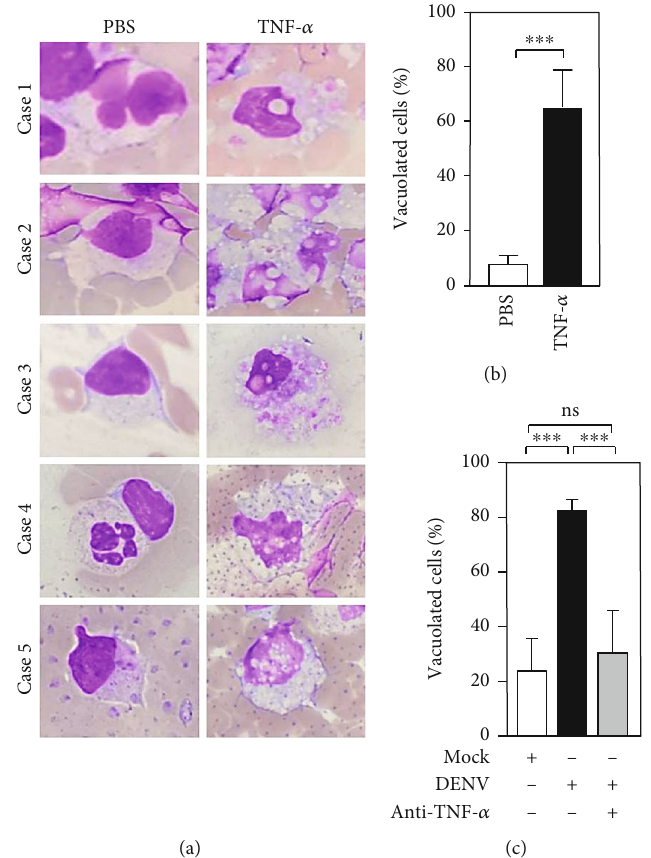
Figure 6: Abnormal TNF- α determines the cytopathological e ff ects 24h postincubation. Without DENV coculture, hTNF- α (100ng/ml) was added to the ex vivo culture of WB for 24 h. (a) Image analysis, shown by an oil immersion fi eld (100x objectives), was performed using the Wright-Giemsa stain to show the induction of vacuolization in fi ve cases. (b) The percentages of vacuolated cells were calculated in the counting area with a high-power fi eld (40x objectives). The quantitative data are depicted as the mean ± SD obtained from fi ve cases. ∗∗∗ p < 0 : 001 , compared to the PBS group. PBS was used as a control. (c) With or without hTNF- α neutralizing antibody (Ab; 50 μ g/ml) cotreatment, DENV ( MOI = 1 )-induced vacuolization was monitored. The percentages of vacuolated cells were calculated in three di ff erent visible areas. ∗∗∗ p < 0 : 001 , compared to the mock group. ns: not signi fi